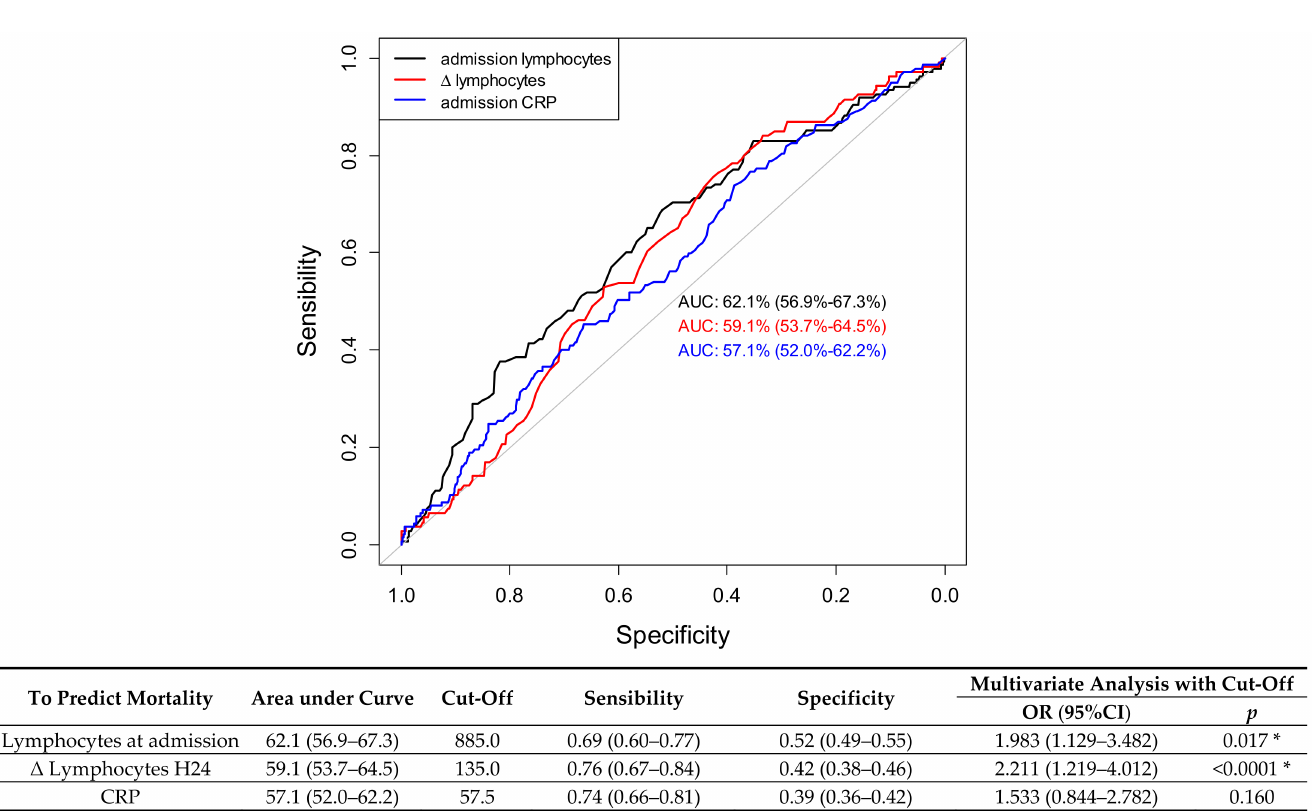
Figure 2. Receiver operating characteristics curve (ROC) for ability of lymphocyte and early variation to predict mortality. Legend: CRP = C reactive protein, * = p <